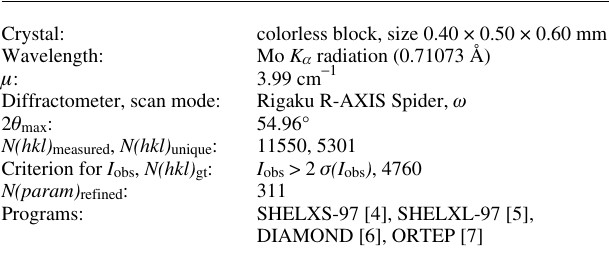
Table 1. Data collection and handling.